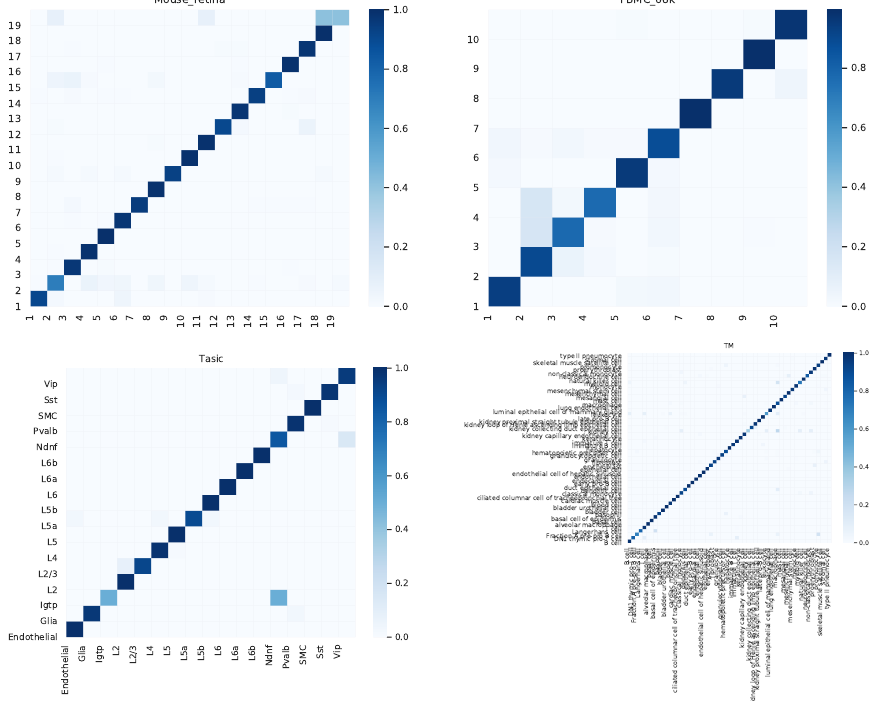
Figure 7. Confusion matrix for healthy cells as examples. We observe that the proportions of cells incorrectly predicted are very low and the overall predictive power of scAGN is very high. The only notable incorrect prediction is the Tasic dataset, where roughly 50% of Pvalb cell types were incorrectly classified as L2 cell